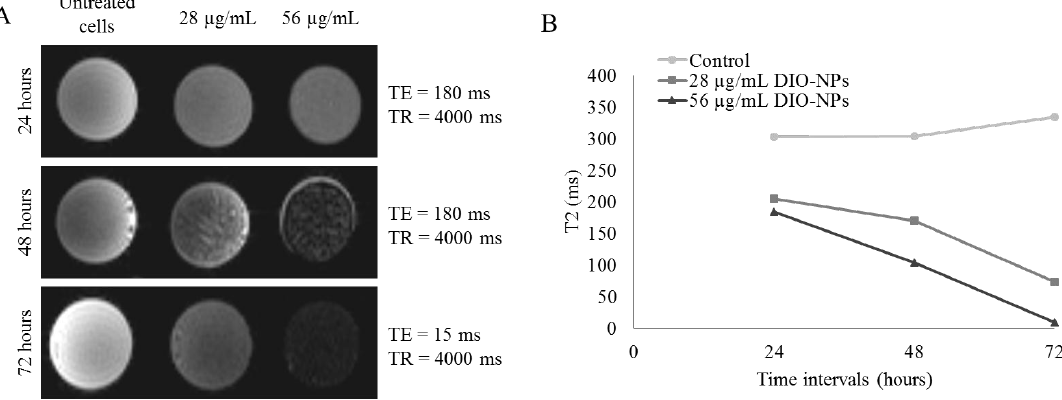
Figure 8. In vitro MRI of Jurkat cells treated with 28 and 56 µg/mL DIO-NPs after 24 h, 48 h, and 72 h. ( A ) Images acquired at 7 Tesla using a Bruker PharmaScan MRI instrument of gelatin phantoms containing human lymphoblasts labeled with DIO-NPs. ( B ) Graphic representation of T 2 values (ms).